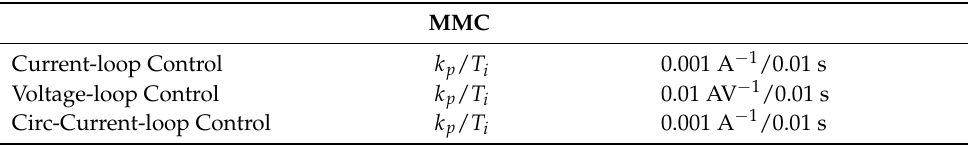
Table A1. Control Gains of the MMC.